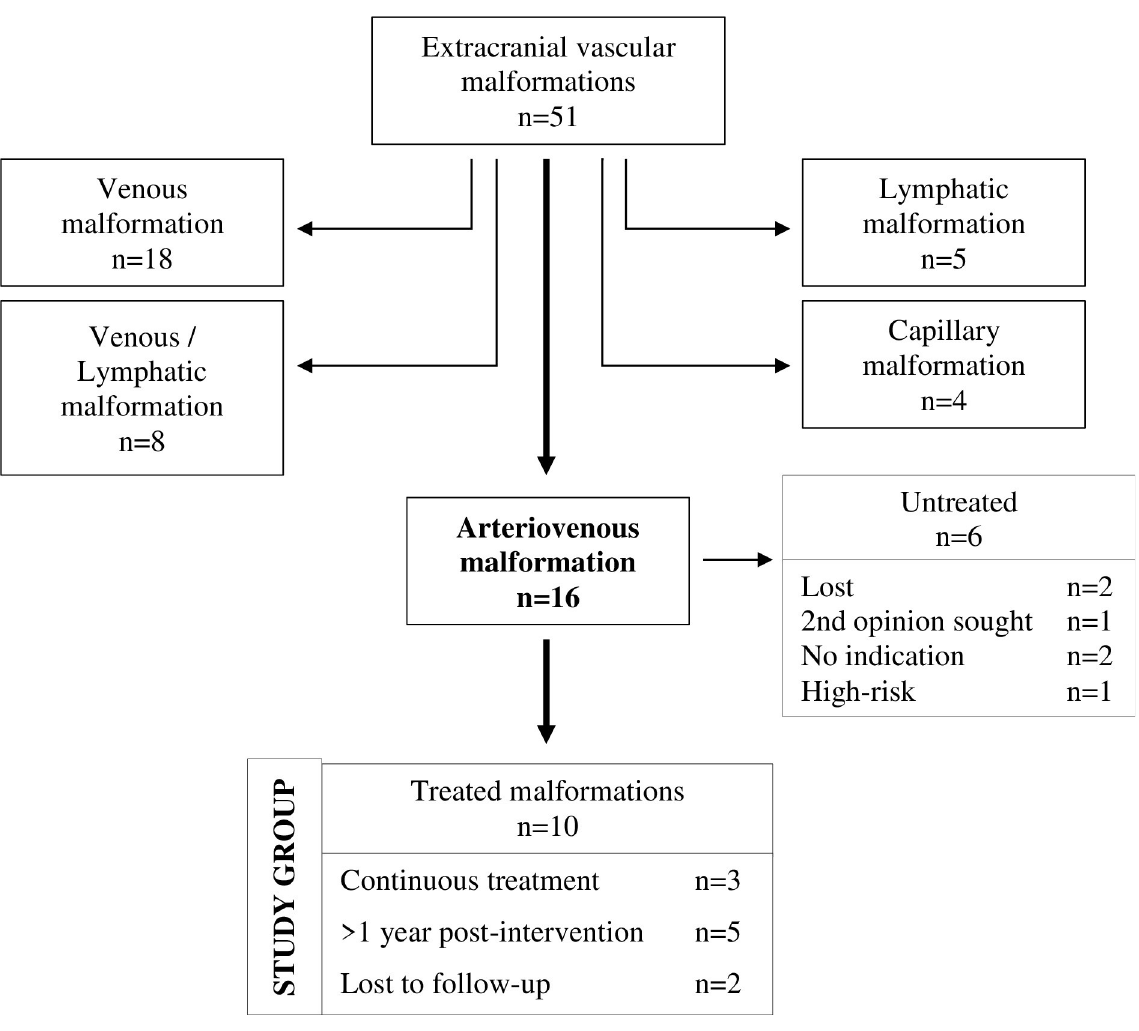
Fig 1. Flow-chart of study group